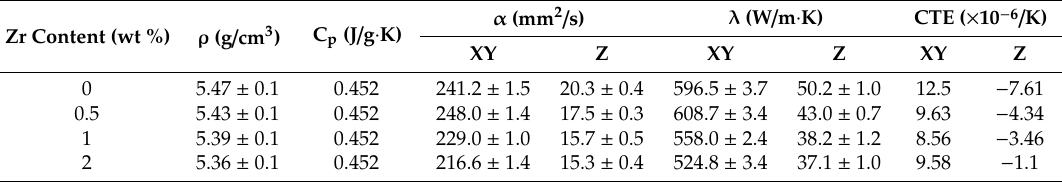
Table 1. Thermal properties of FG / Cu composites with various Zr